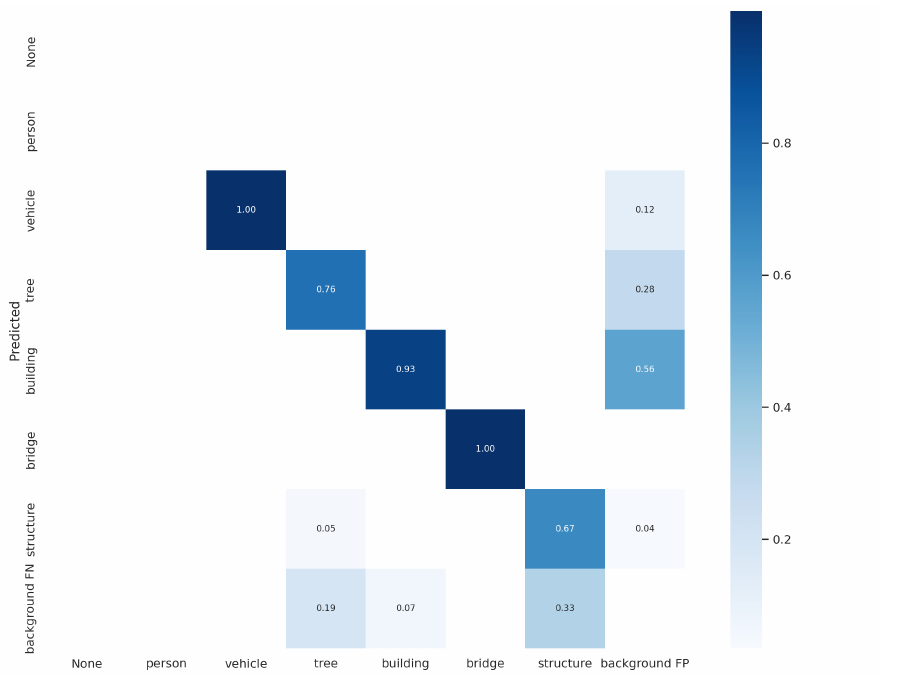
Figure 7. The confusion matrix after training the model. Vehicles, bridges, and buildings were able to be accurately detected, demonstrating how good the prediction was.